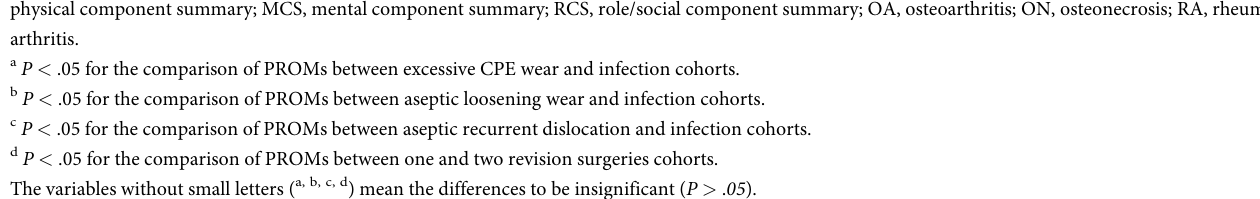
average post-operative satisfaction score was 82.5 ± 19.6 (range: 25–100) (Table 3). The effect of the underlying reason for revision THA on PROMS is shown in Table 4. The post-operative PCS in the infection subcohort (29.0) was significantly lower ( P < .05) than the PCS in the excessive CPE wear (45.4), aseptic loosening (47.6), and recurrent dislocation (50.7) subco- horts. The post-operative PCS and RCS were significantly lower in the two revision (re-